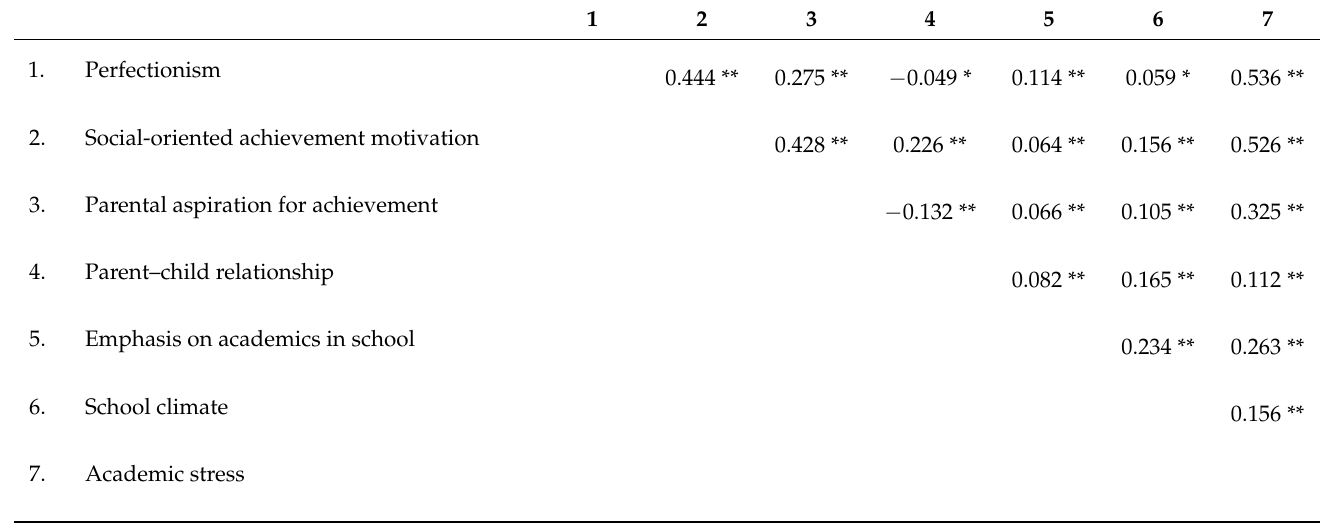
Table 2. Intercorrelations between variables in this